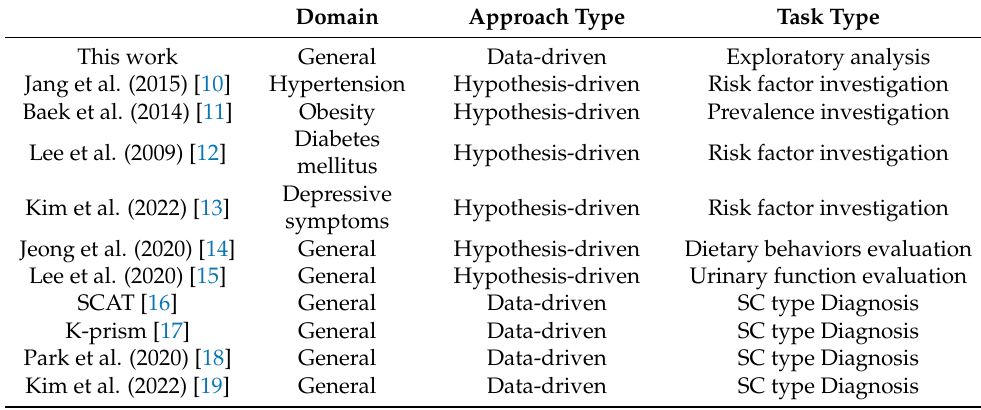
Table 1. Comparison with previous studies on clinical data analysis on Sasang